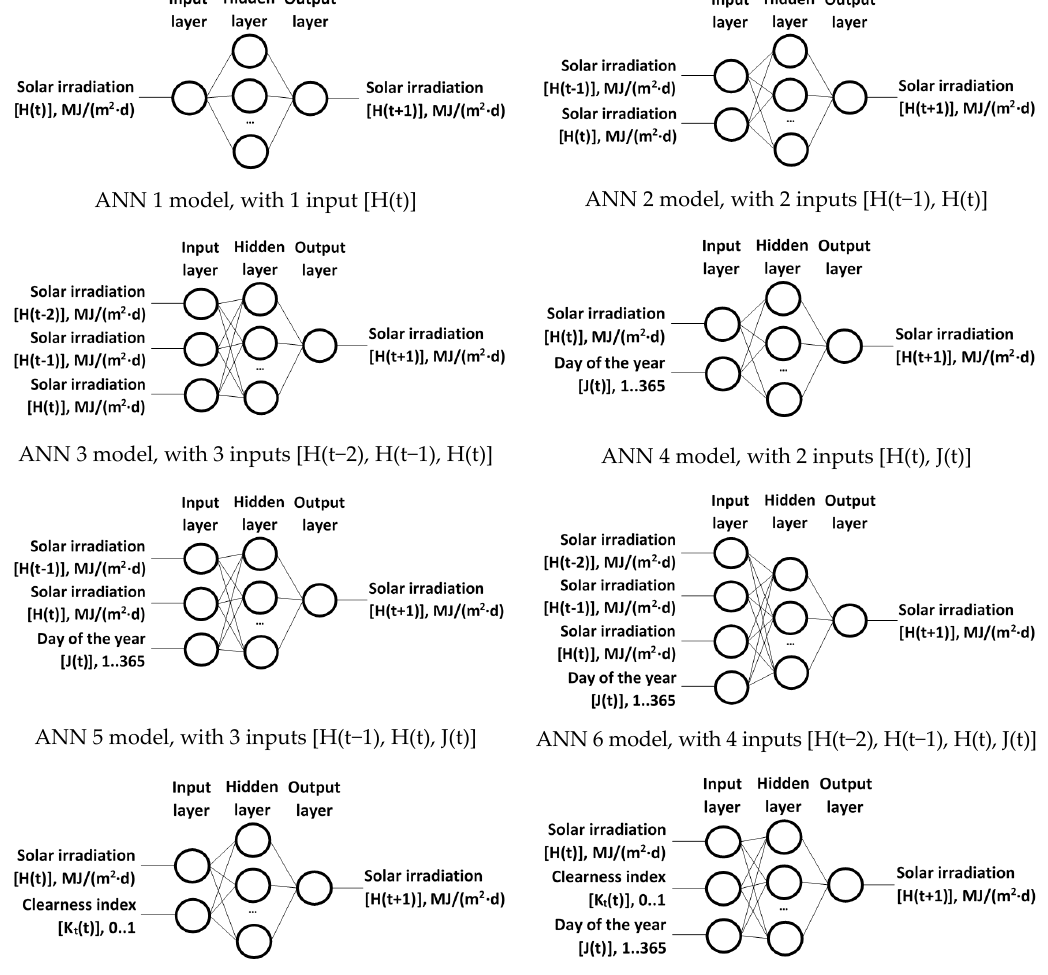
Figure 1. Evaluated artificial neural network (ANN) architectural models based on input variables.